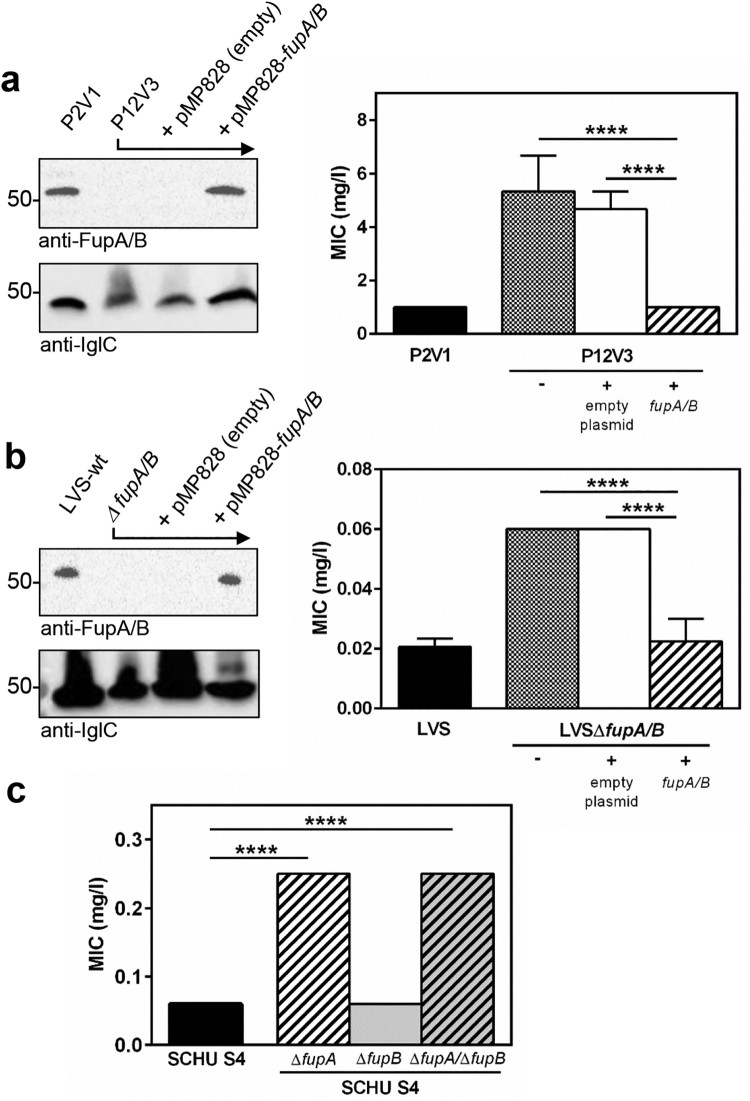
Restoration of ciprofloxacin resistance phenotype in fupA/B-complemented mutants. (a) Left panel: FupA/B expression was evaluated by western-blot and using anti-IglC as positive control on whole lysates of LVS mutants resulting from directed-evolution experiments [4] showing that protein expression in P12V3 is restored upon gene trans-complementation using the plasmid pMP828. Right panel: The same strains were assayed for ciprofloxacin susceptibility, measured as MIC values. (b) Same experiments performed on LVS and LVSΔfupA/B strains. (c) Ciprofloxacin-susceptibility of F. tularensis SCHU S4 as well as ΔfupA, ΔfupB and the double ΔfupA/ΔfupB deletion mutants. MIC were determined from triplicate cultures from three different experiments. **** P < 0.0001.